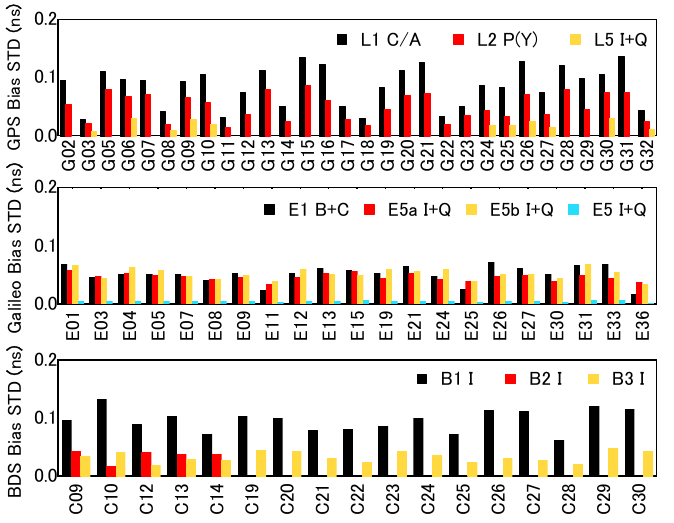
Figure 5. Standard deviations (STDs) of receiver-related pseudorange biases of baseline ZIM2_ZIM3 from DOY 101 to 160, 2019.